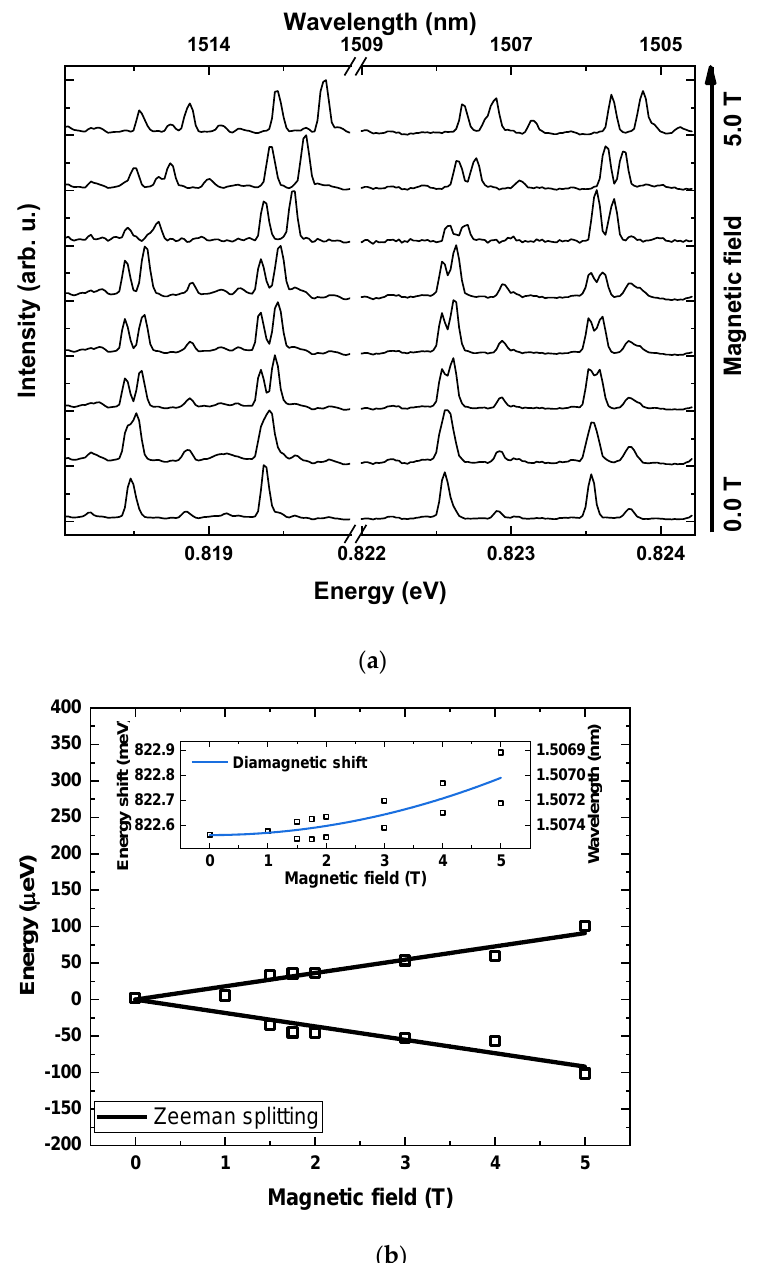
Figure 5. Faraday configuration PL spectra. ( a ) PL spectra for magnetic fields from 0 to 5 T. ( b ) Energy of optical transitions versus magnetic field, after subtraction of the diamagnetic shift (open black squares). Black lines are fits to Zeeman energy. Inset shows as measured energy of optical transitions versus magnetic field, without subtraction of diamagnetic shift (blue line).